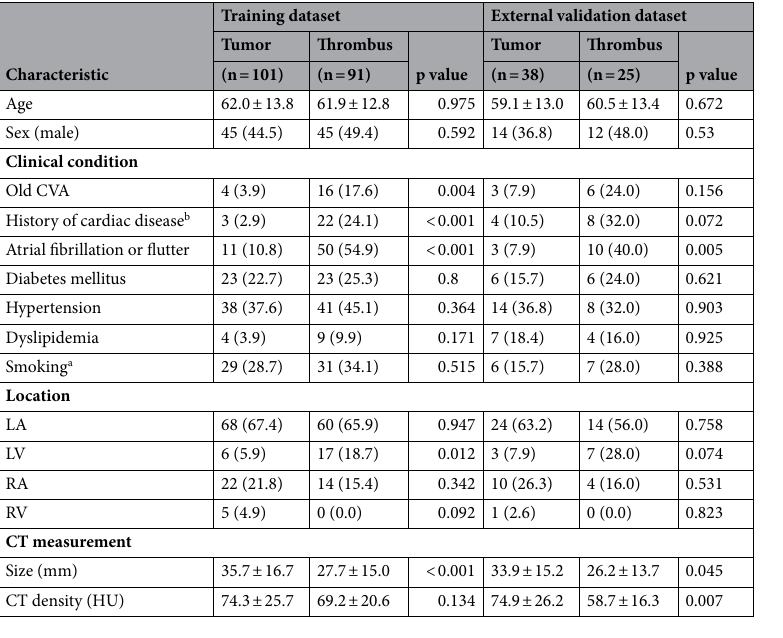
Table 1. Baseline characteristics of training and validation study datasets. Values are presented as mean value (± standard deviation) or patient number (%). CT computed tomography, CVA cerebrovascular accident, HU hounsfield unit, LA left atrium, LV left ventricle, RA right atrium, RV right ventricle. a Current or former smoker. b Cardiac disease includes valvular heart disease and congestive heart